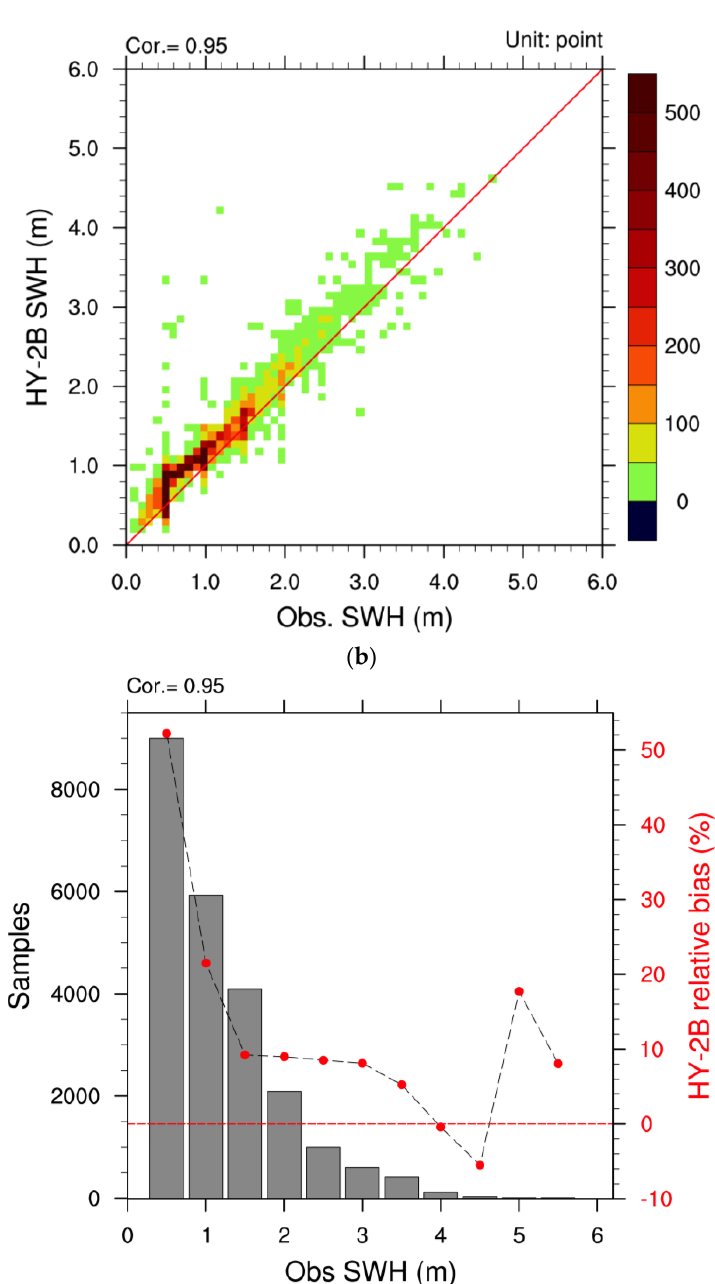
Figure 5. As in Figure 2, but for the SWH of HY − 2B compared to that of 30 buoys, where red dots indicate the relative bias of HY−2B SWH against observation and 24,896 matched SWHs were used. Comparing the CFOSAT and HY − 2B in − situ − validation results, CFOSAT and HY − 2B both showed a close relationship according to observations made. CFOSAT and HY − 2B tended to overestimate the SWHs in the range of <2 m; moreover, HY − 2B probably over- estimated the SWH in the range of <1.25 m more than CFOSAT. CFOSAT showed a rela- tive advantage in the SWH range of 3.5 – 4.5 m.